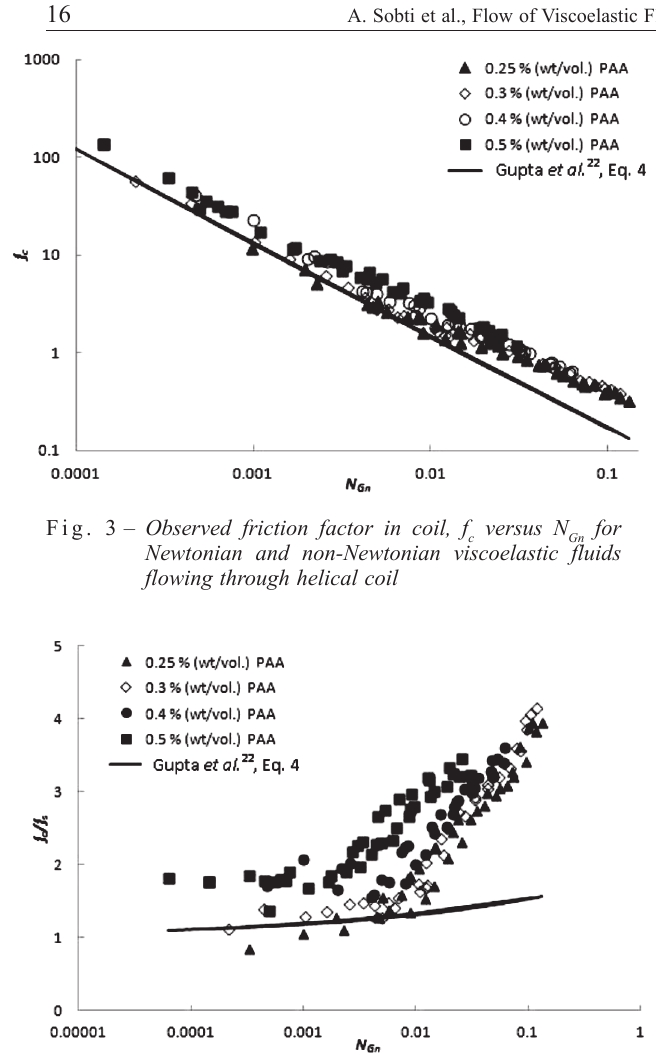
Fig. 4 – Friction factor ratio (f and non-Newtonian viscoelastic fluids flowing through helical coil